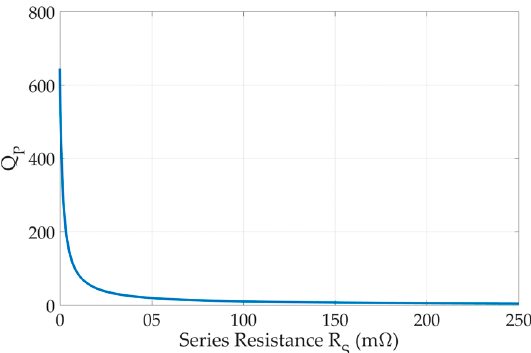
Figure 15. The quality factor on the transmitter circuit, Q P , corresponds to the series resistance increment.